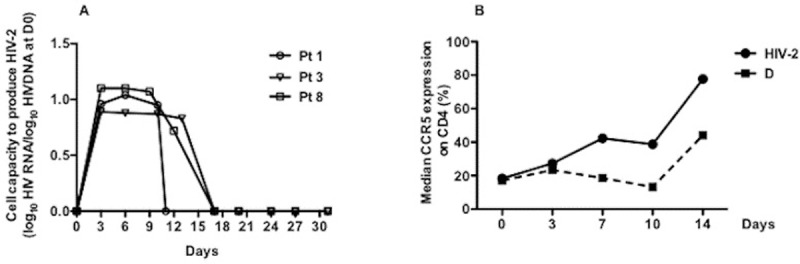
A)
In vitro inducibility of HIV-2 reservoir in CD8-depleted peripheral blood mononuclear cells (PBMCs). Cell capacity to induce HIV-2 replication was evaluated in 11 HIV-2 infected subjects by stimulating CD8-depleted PBMC with anti-CD3/anti-CD28 co-stimulation plus IL-2, plus IL-7 plus IL-15. Allogeneic feeder CD8-depleted PBMC from a donor were added to culture at D13. Culture supernatants were collected every three days for HIV-2 viral load quantification from D0 to D31. Results are expressed as the log10 of the ratio between the numbers of HIV-RNA copies quantified on a given day of culture and the level of total HIV-DNA in the subset measured at D0 of culture. Each symbol represents a subject. B) Expression of CCR5 in culture on CD4 T-cells from 7 HIV-2 infected subjects (dot) compared to 7 donors (D) (square). Median expression of CCR5 on CD4 T-cells during 14 days of culture is represented.